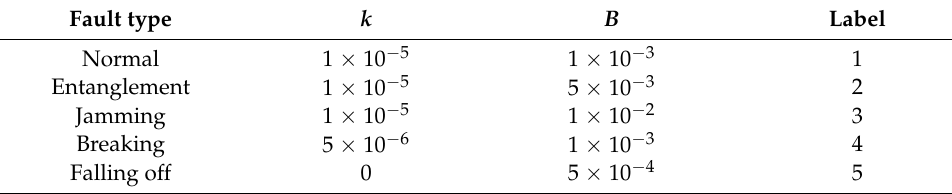
Table 4. Fault characteristics parameters of the thrusters (training